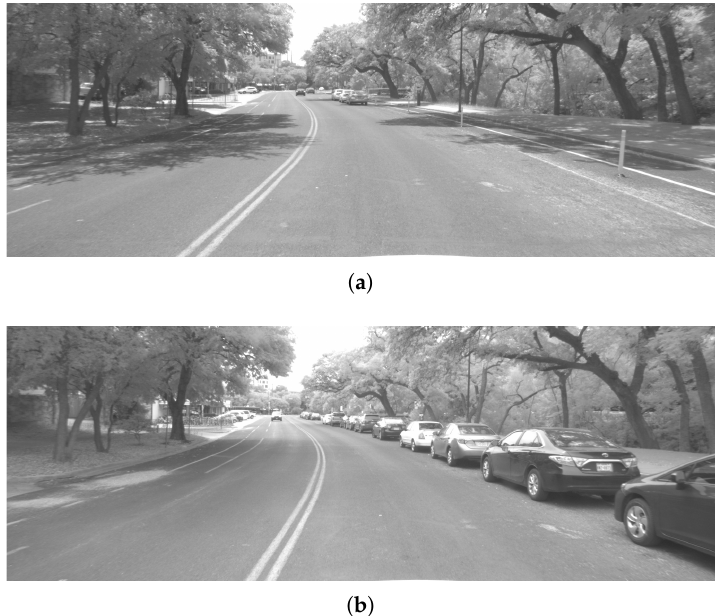
Figure 12. Different visual conditions on two days of data collection. ( a ) An image captured on the first day of data collection. Note the sharp shadows and absence of parked cars. ( b ) An image captured on the second day of data collection. Note the absence of sharp shadows and complete blockage of curb due to parked